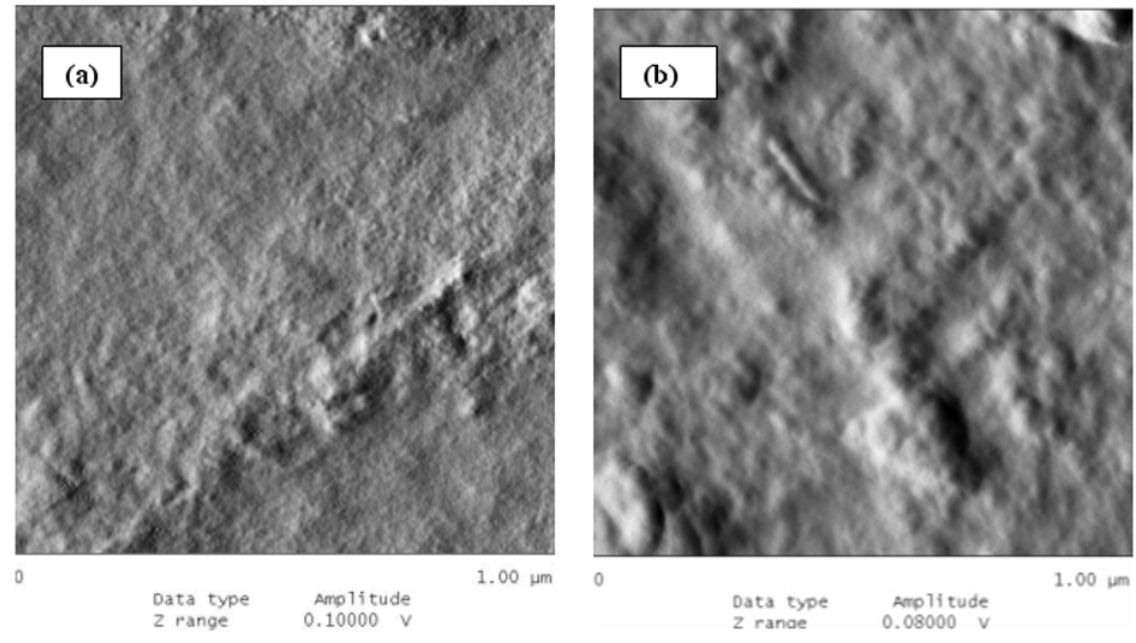
Figure 8. AFM scans of the Lewatit MonoPlus M 500 before (a) and after (b) the sorption process of Cu(II)-MGDA complexes. Table 4. Thermodynamic parameters for the sorption of Cu(II)-MGDA complexes on Lewatit MonoPlus M 500, Lewatit MonoPlus M 600 and Lewatit MP 62. Ion